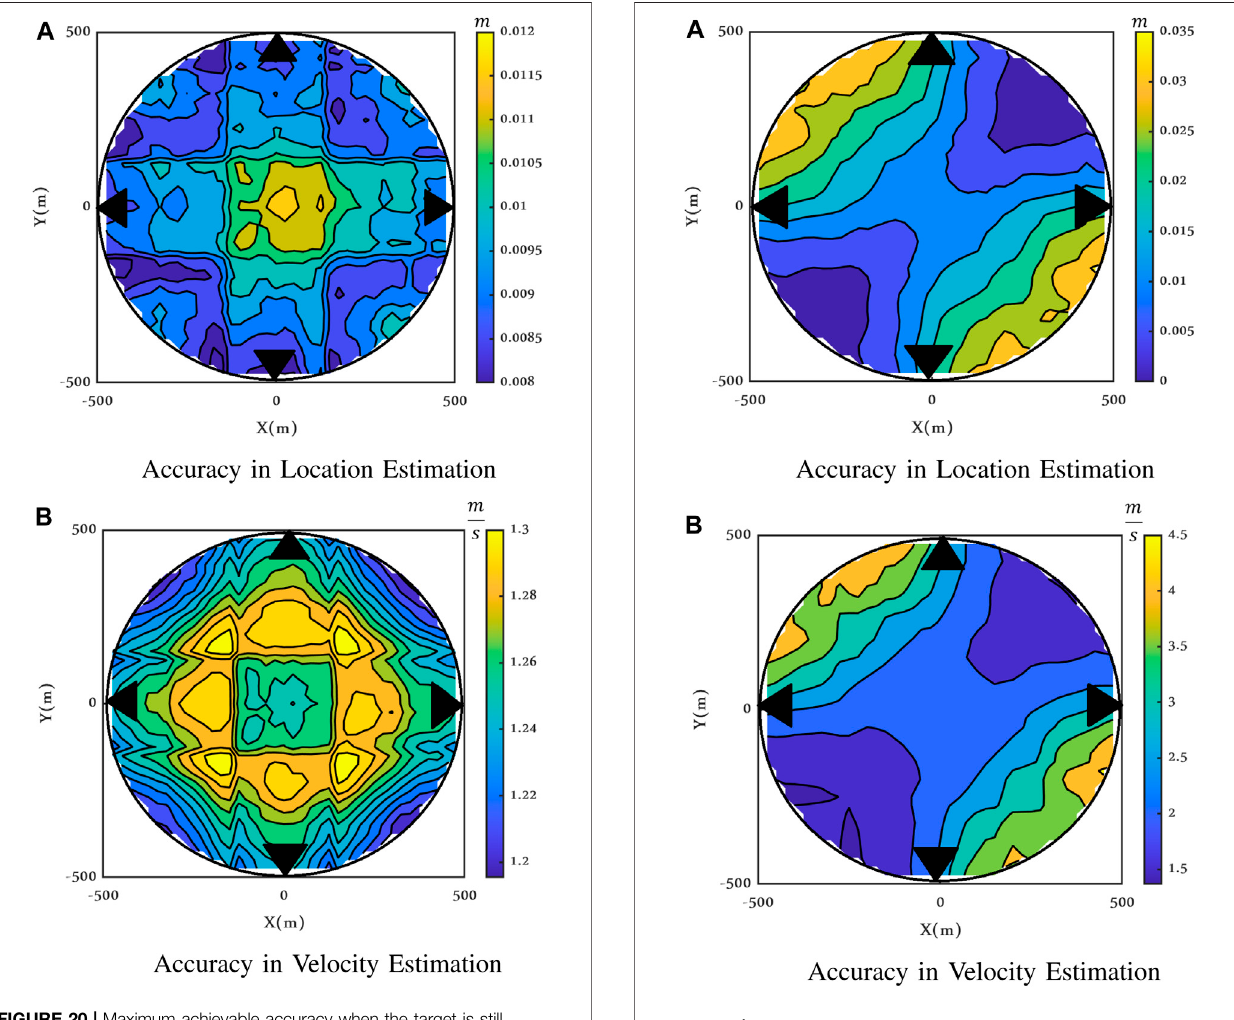
FIGURE 21 | Maximum achievable accuracy when the target is moving, Clutter Model II, ρ = 0, ] = 2.1, and SCR = − 15